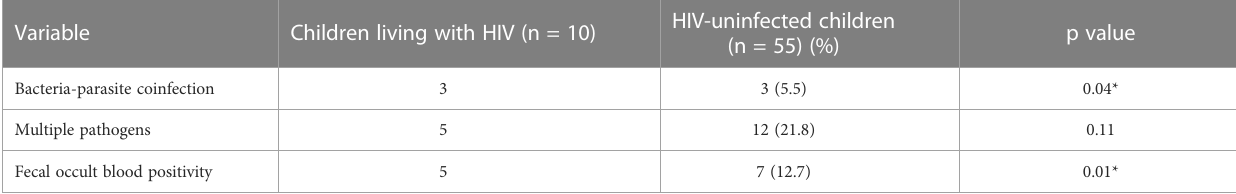
TABLE 4 Markers of severity: Multiple pathogens and occult blood in stool specimens from children with diarrhoea.